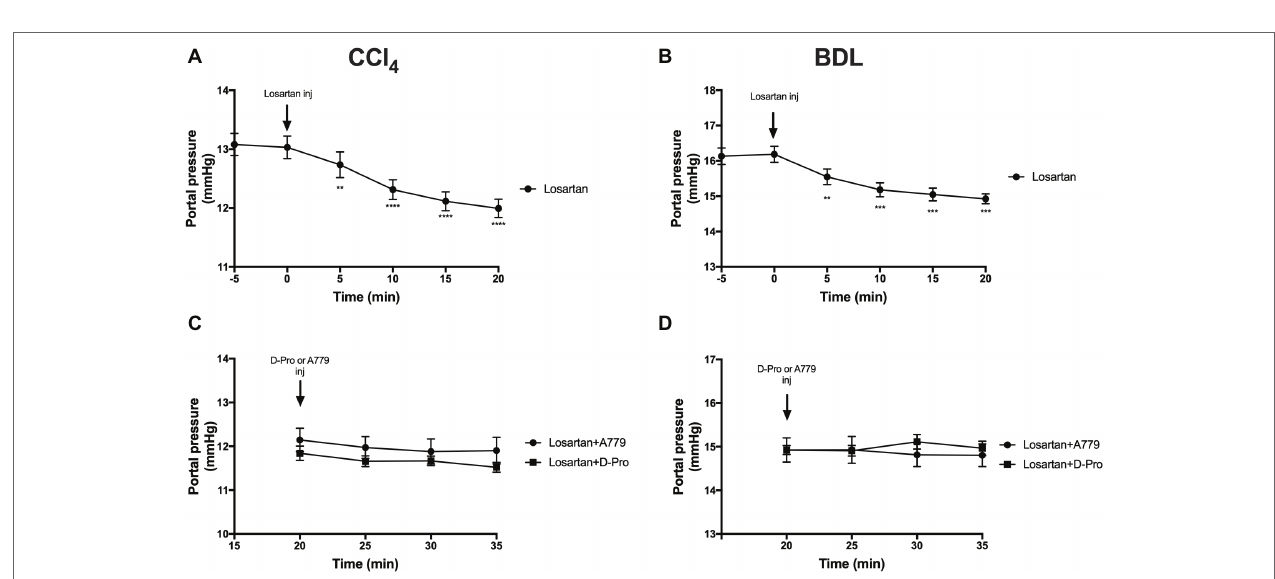
FIGURE 6 | Changes in portal pressure after the treatment with AT1R blocker losartan (1 mg/kg) in the CCl 4 (A) and BDL (B) models. Note that the two groups that received losartan injections in each model were pooled for t -test analysis. Bottom panels show portal pressure of the two losartan groups after receiving either MasR blocker A779 (10 μ g/kg) or MrgD blocker D-Pro (10 μ g/kg) in the CCl 4 (C) and BDL (D) models. Losartan significantly reduced portal pressure in all groups; however, A779 or D-Pro which was given 20 min after losartan failed to affect portal pressure. Each time point represents the mean ± SEM profile from 12 to 14 (A,B) or 6 to 7 (C,D) rats per treatment group. Data in (C) and (D) were analyzed by repeated-measures ANOVA. ** p < 0.01, *** p < 0.001, **** p < 0.0005 baseline vs. post-losartan injection.